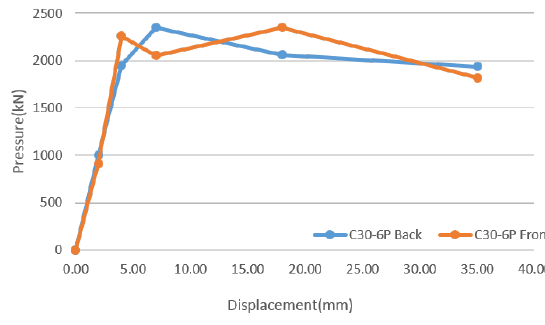
Figure 10. Shortening of C30 6P according to pressure